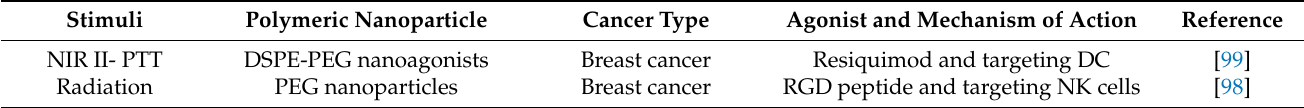
Figure 5. Delivery of agonists. ( a ) Schematic representation of APNA. ( b ) Mechanism of the antitumour immune response of the polymer APNA via NIR-II photothermal immunotherapy, in which tumour-associated antigens and damage-associated molecular patterns are released, activating DCs. [99] Copyright Nature Communications. Table 7. Exogenous stimuli-based polymer nanoparticles for delivery of